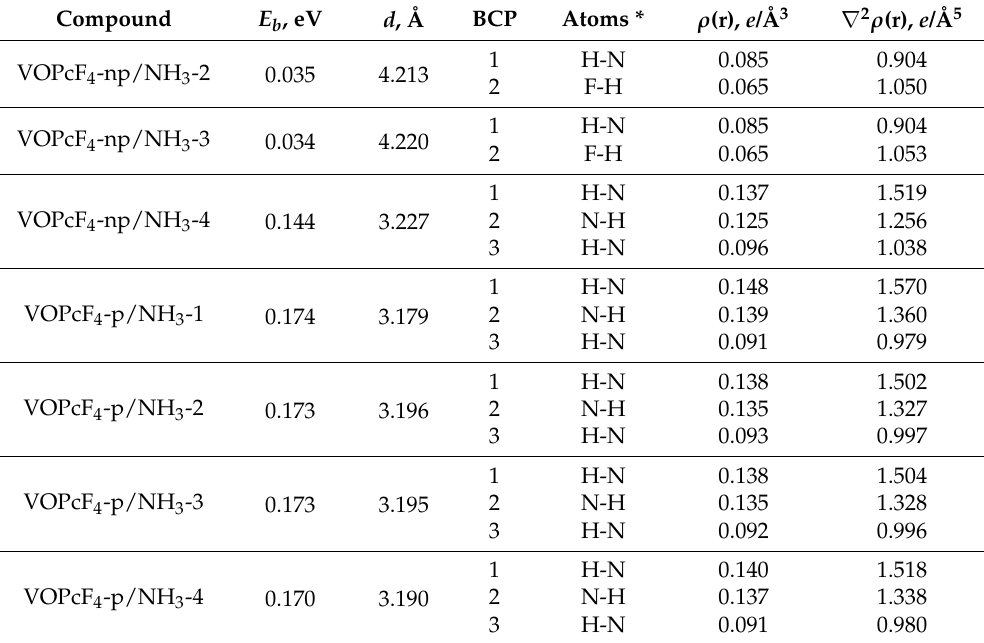
Table 3. The interaction parameters of the NH 3 molecule with vanadyl